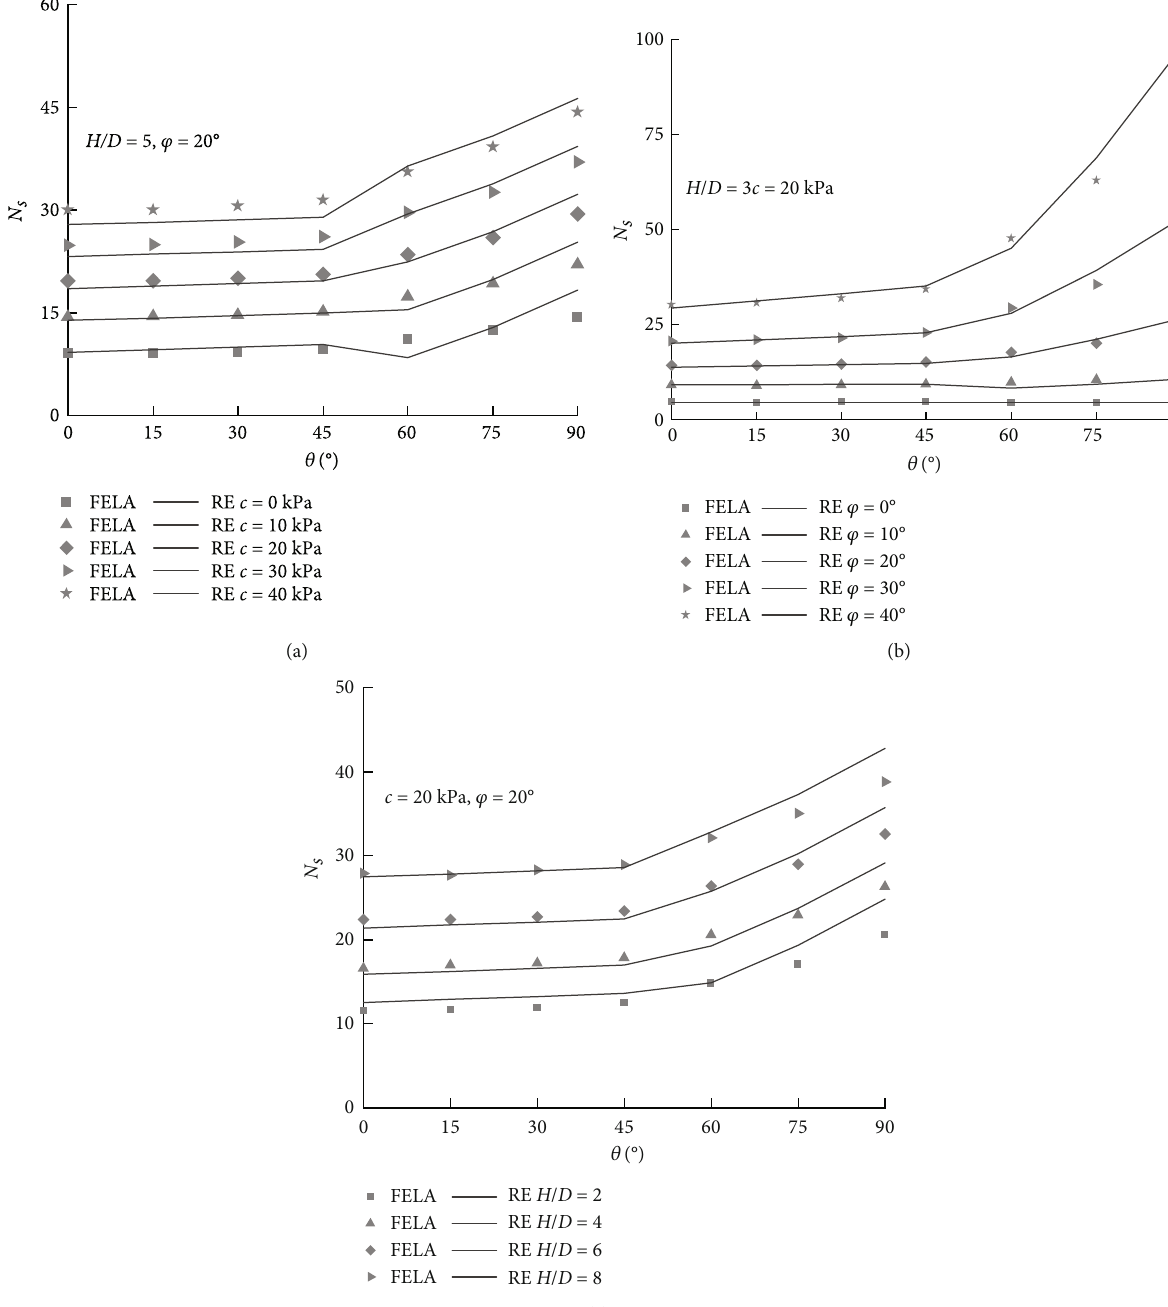
Figure 9: Comparison of numerical simulation results and regression results for di ff erent (a) cohesion, (b) internal friction angle, and (c) H / D